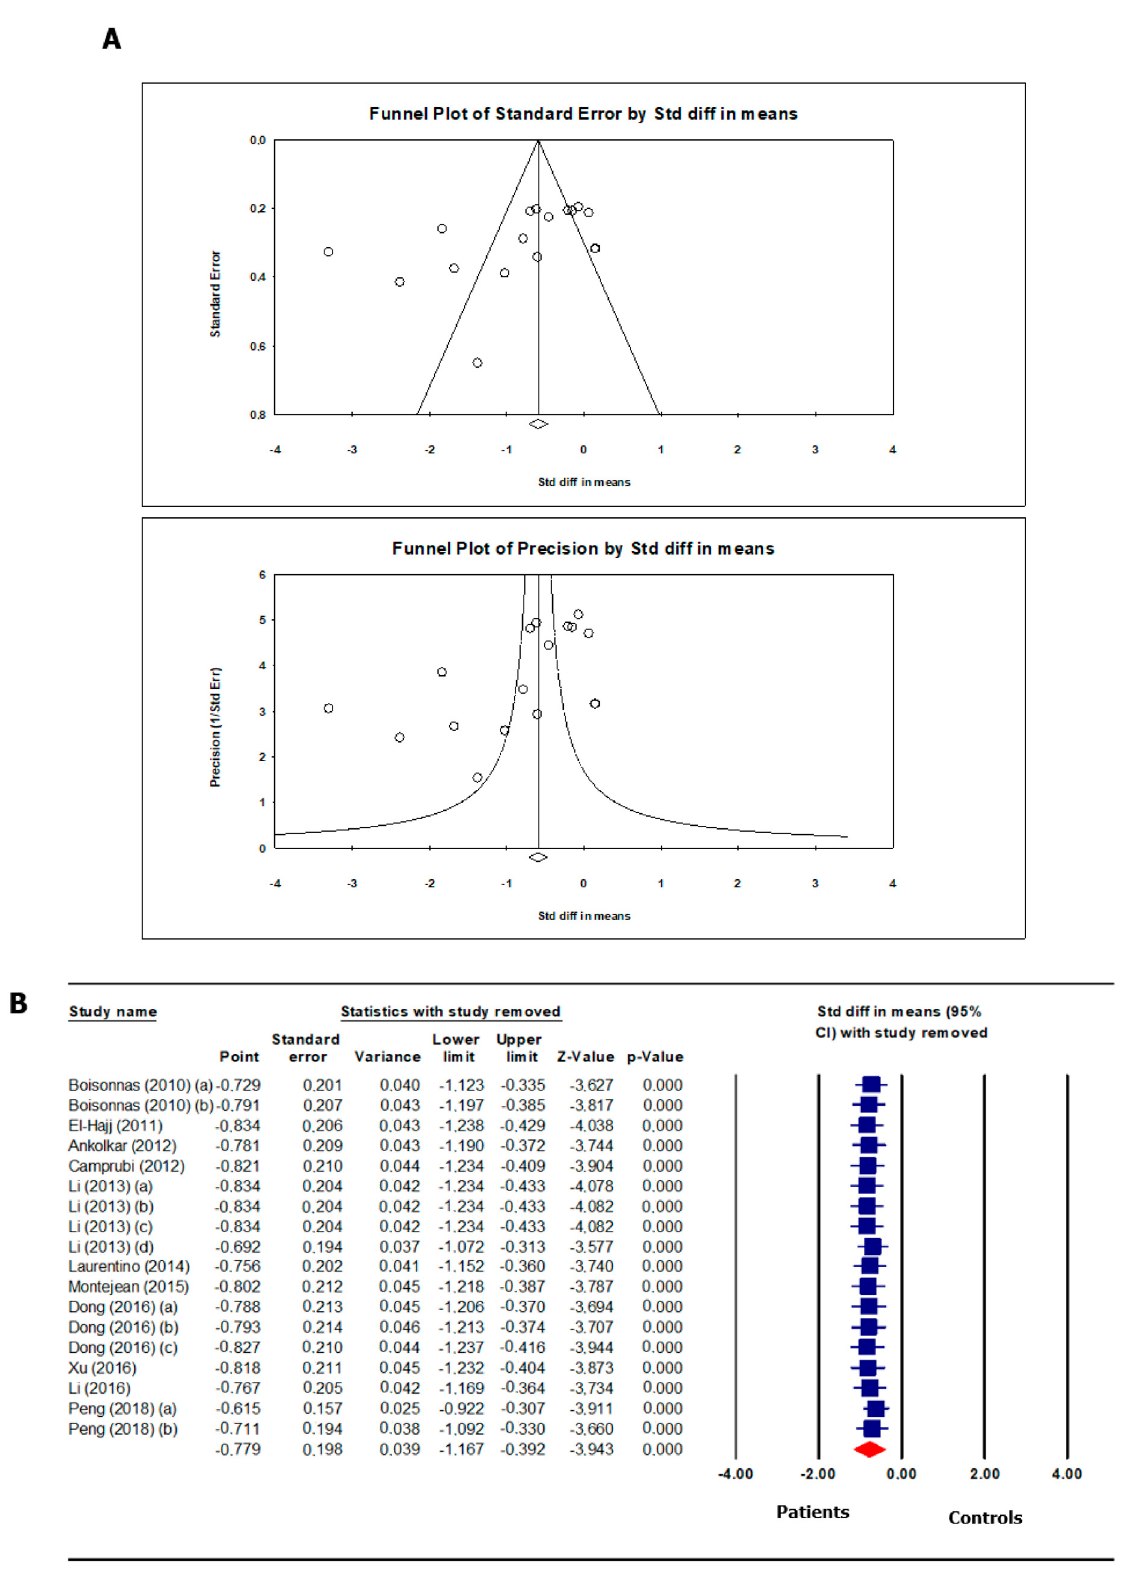
Figure 3. Funnel plot ( A ) and sensitivity analysis ( B ) of H19 gene methylation in spermatozoa of patients with infertility/abnormal sperm parameters and controls. The studies included in the funnel plot and in the sensitivity analysis are: [21–30,34]. Blue squares represent the standard di ff erence of the mean after removal of the studies corresponding to the speci fi c square. The read diamond is the overall standard di ff erence of the mean without any study removal.